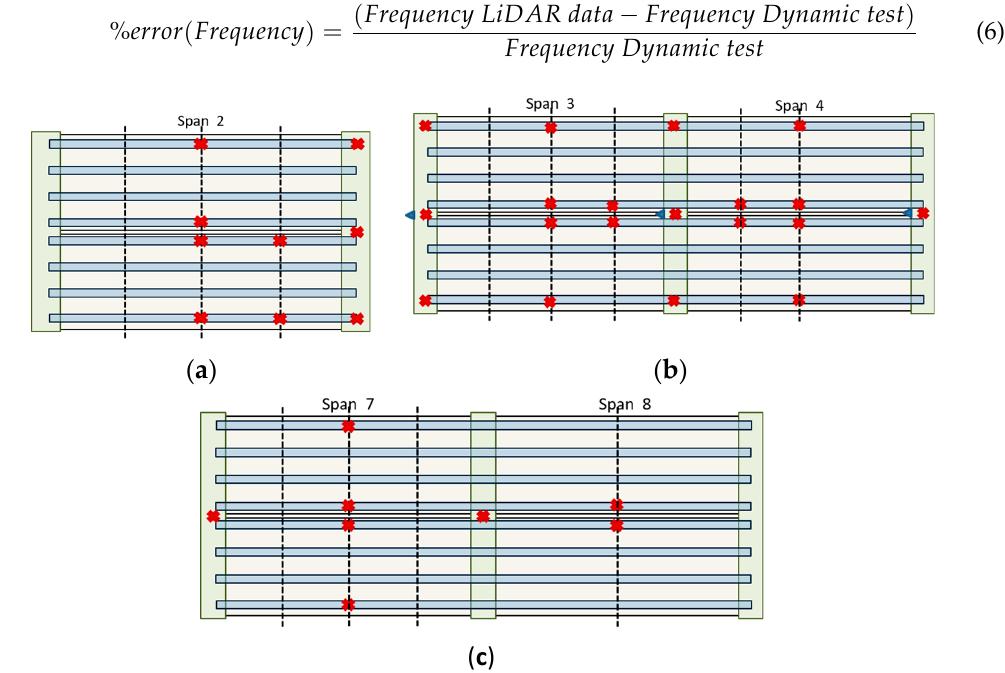
Figure 4. Instrumentation Layout: ( a ) Span 2; ( b ) Spans 3 and 4; ( c ) Spans 7 and 8. Mode 1—2.02 Hz